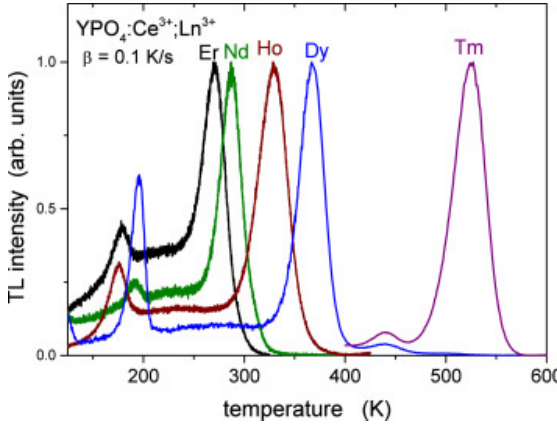
Figure 13. Thermally stimulated glow curves of YPO 4 :Ce 3+ ,Ln 3+ (Ln = Er, Nd, Ho, Dy, and Tm). The plateau before the main peak of the samples with co-dopants Er, Nd, Ho, and Dy is caused by tunnelling recombination (localized transition). The main peaks are caused by recombination via the conduction band (non-localized transition).